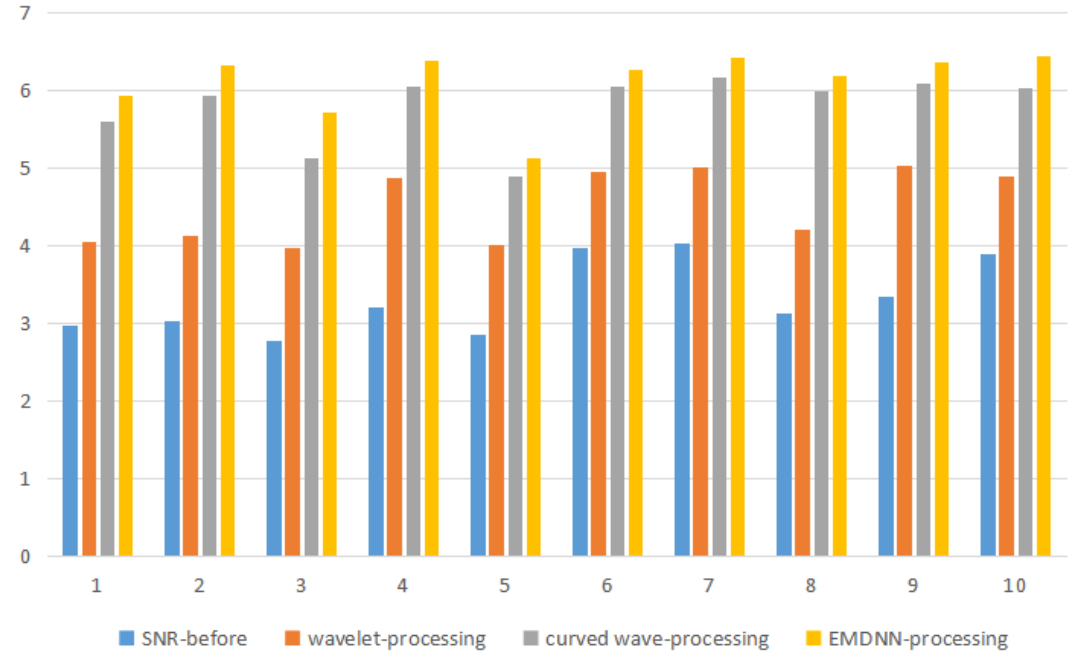
Figure 11. The contrast chart of SNR (original and the processed simulated data).